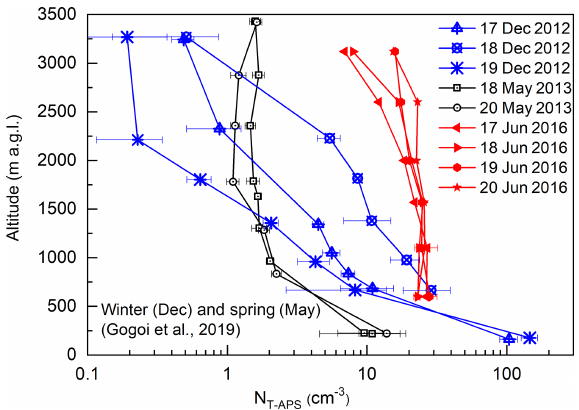
Figure 15. Vertical profiles of seasonal mean values of aerosol num- ber concentrations ( N T , as measured by APS in the size (diameter) of regime 0.5 to 20µm) at Jodhpur during winter 2012 (17–19 De- cember), spring 2013 (18 and 20 May) and just prior to the onset of the monsoon 2016 (17–20 June).